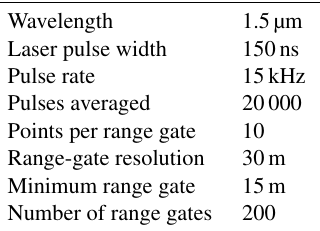
Table 1. Main technical specifications of the ARM Halo